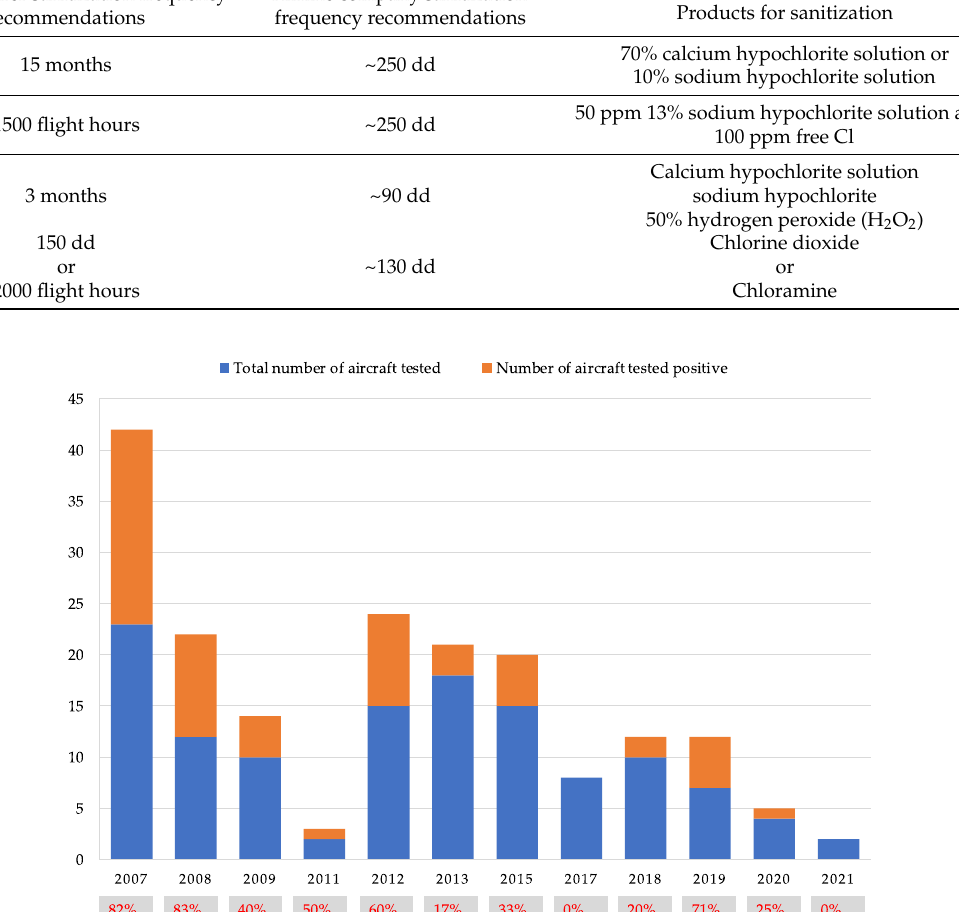
Figure 4. The number of aircraft tested and the number of those found positive—divided by survey year. The percentages of positivity found for each year of investigation are also shown. The average positivity rate for the entire period was 45%. Figure 5 shows the total number of aircraft that tested positive (positivity is always for Legionella > 100 CFU/L).